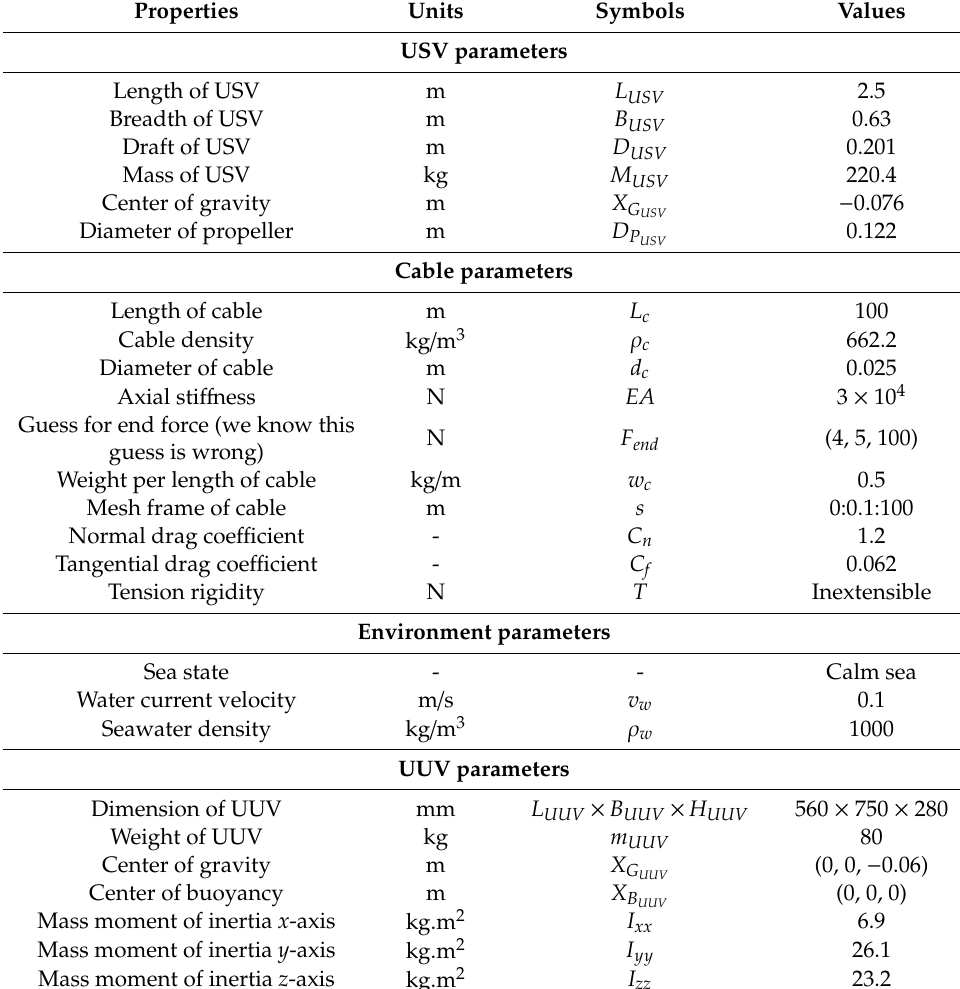
Table 1. The parameters for the